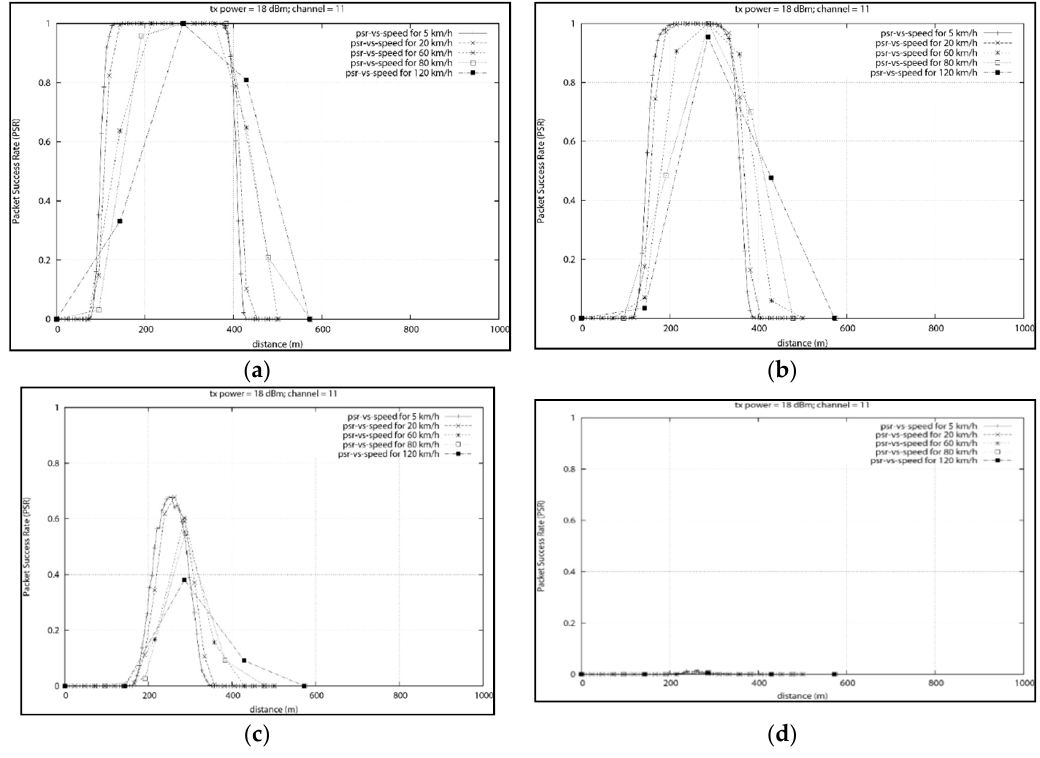
Figure 25. PSR vs. Speed with concentrator at position x = 250 m and various y positions ( a ) y = 100 m ( b ) y = 150 m ( c ) y = 180 m ( d ) y= 200 m.